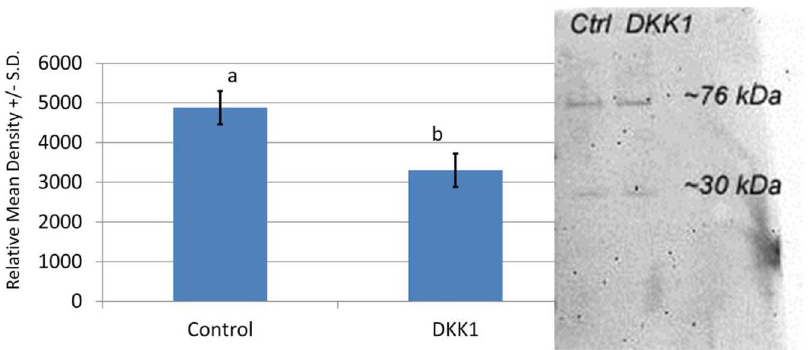
Figure 2. Western blot of DVL1 in oocytes matured in the presence or absence of DKK1. The mean densitometry of the two bands (30 and 76 kDa) was different between the two treatments a,b